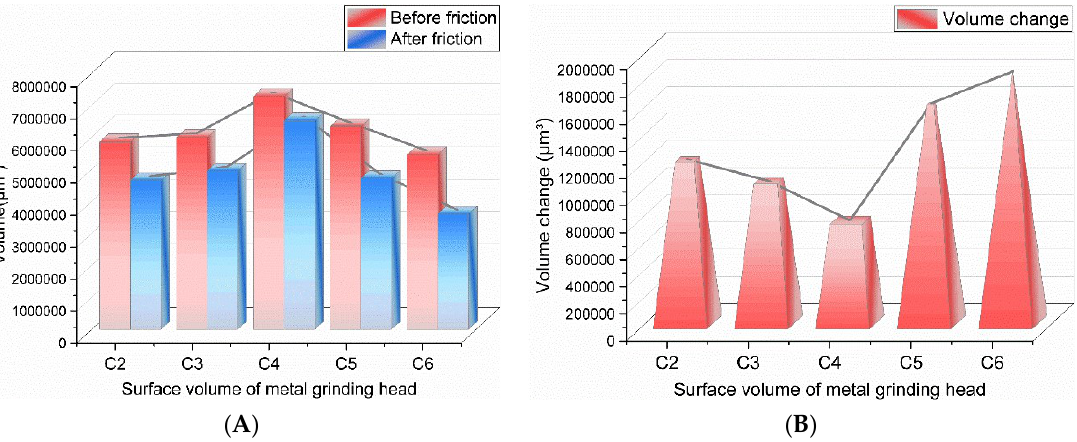
the volume change.)